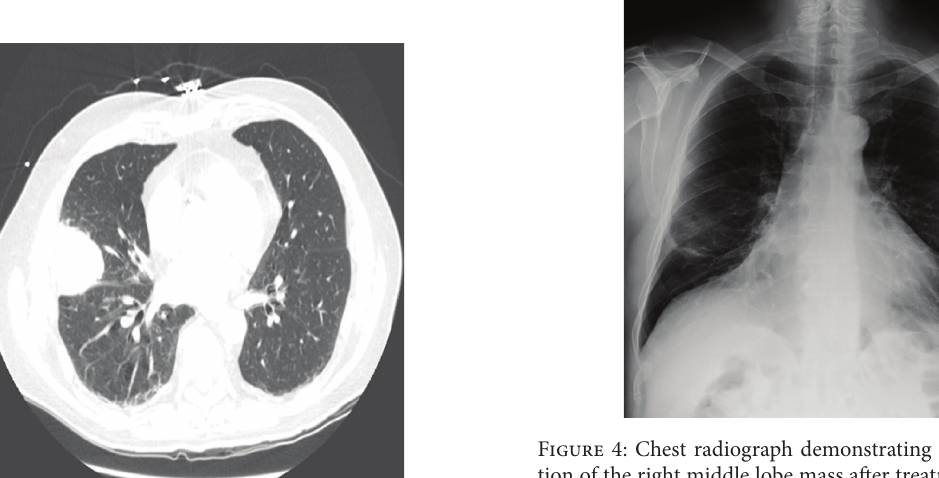
Figure 1: Chest radiograph demonstrating a large mass in the right middle lobe.